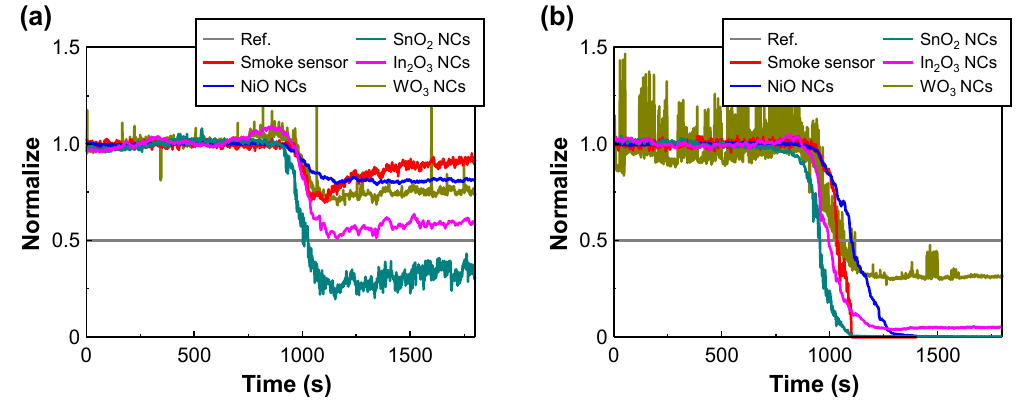
Figure 7. Normalized transient response curves of all samples (SnO 2 , NiO, WO 3 and In 2 O 3 ) and commercial sensor at different hot-plate temperatures: ( a ) 200 °C and ( b ) 350 °C.